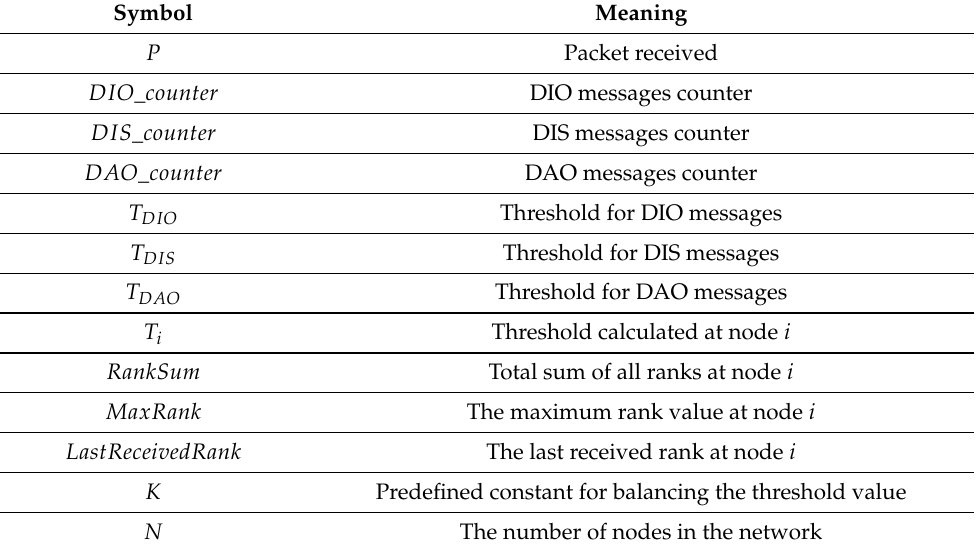
Table 1. Symbols used in Algorithms